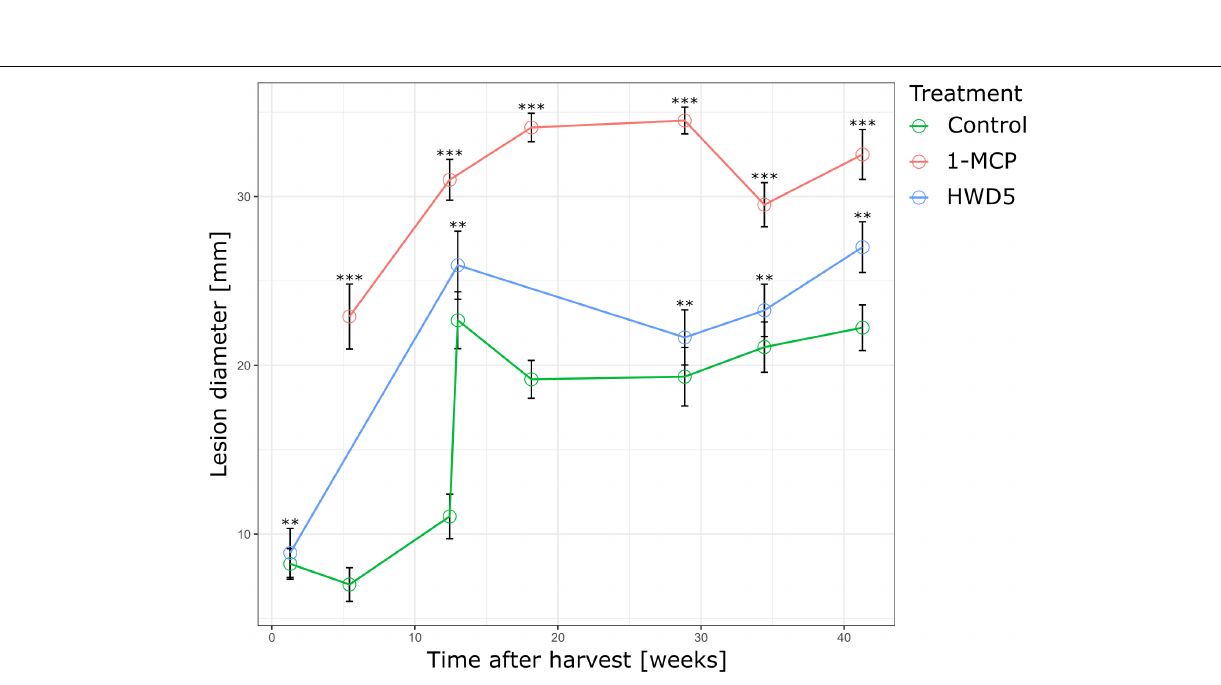
Frontiers in Microbiology |